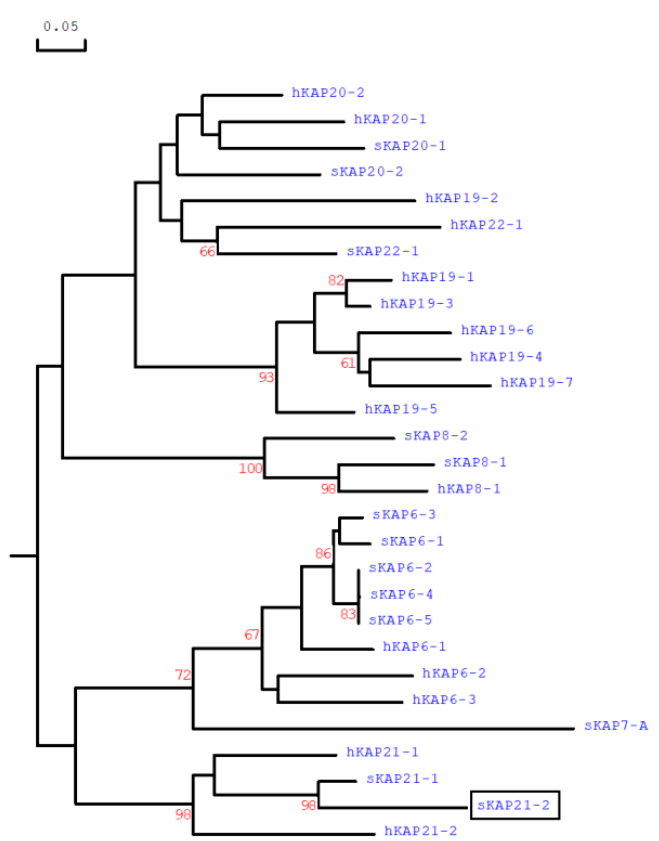
Figure 2. A phylogenetic tree positioning the newly identified ovine KAP21-2 (boxed) relative to selected HGT-KAPs from sheep ( Ovis aries ) and humans ( Homo sapiens ). The tree was constructed using predicted amino acid sequences for many of the proteins. The numbers at the forks of the tree indicate the bootstrap confidence values and only those equal to, or higher than 60%, are shown. The sheep KAPs are indicated with a prefix “s”, while the human sequences are indicated with “h”. The GenBank accession numbers for the ovine HGT-KAPs are: MH243552 and MH071391 (for sKAP20-1 and sKAP20-2 respectively), MF143980 for sKAP21-1 and KX377616 for sKAP22-1, and